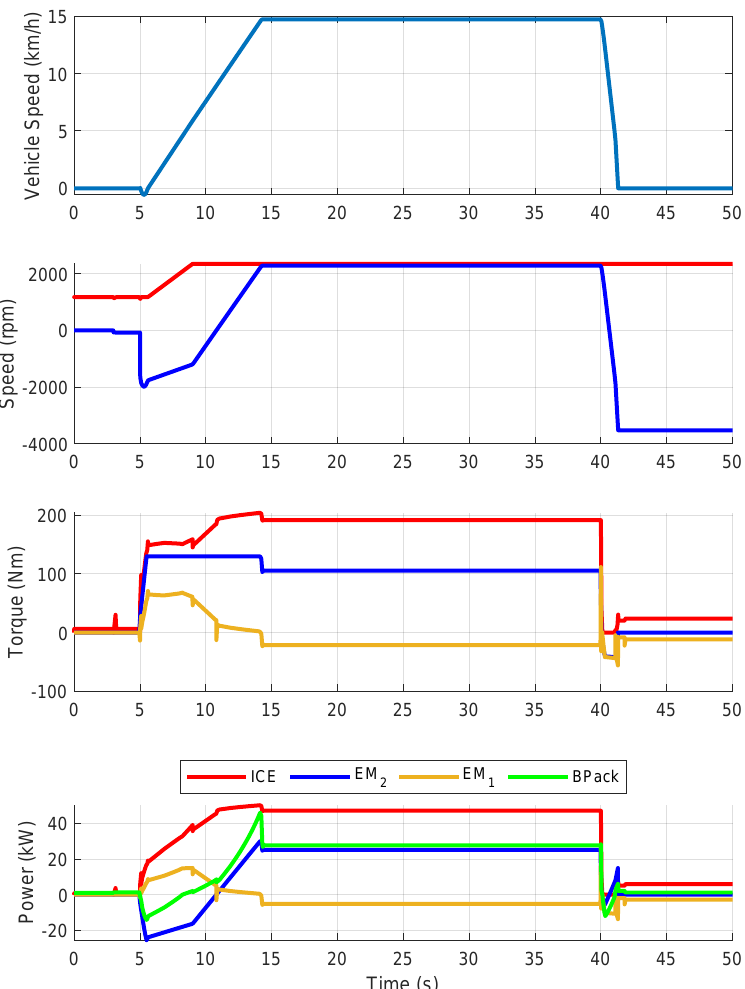
Figure 9. HeCVT 0–15 km/h acceleration test with 5000 kg trailer and 20%